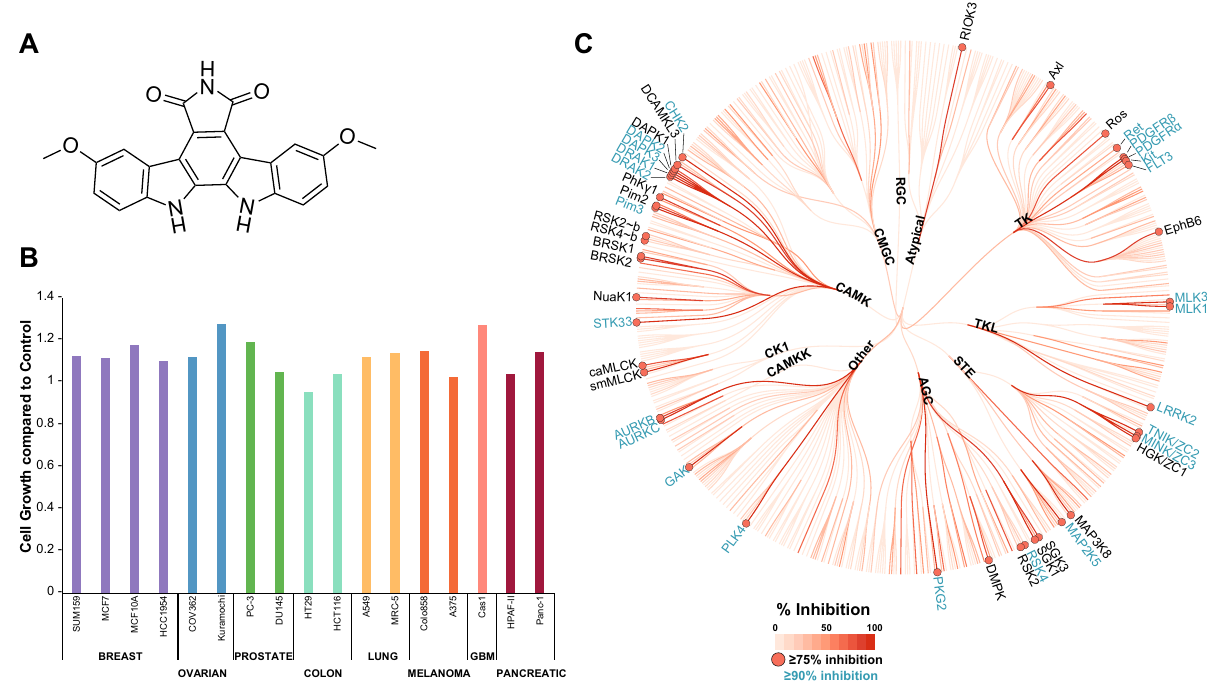
Figure 1. GW296115 potently inhibits kinases with minimal effect on cell growth. ( A ) Structure of GW296115. ( B ) GW296115 does not affect cell growth in multiple cell lines. Cell lines in the panel were treated with 1 μM GW296115 for 72 h (N = 2) and analyzed using the deep dye drop method. MCF10A and MRC-5 are non- malignant cell lines. ( C ) DiscoverX screen identifies 25 kinases with > 90% inhibition and 41 kinases with ≥ 75% inhibition at 1 μM of GW296115. Coral was used to make ( C ): https ://phans tiel-lab.med.unc.edu/CORAL